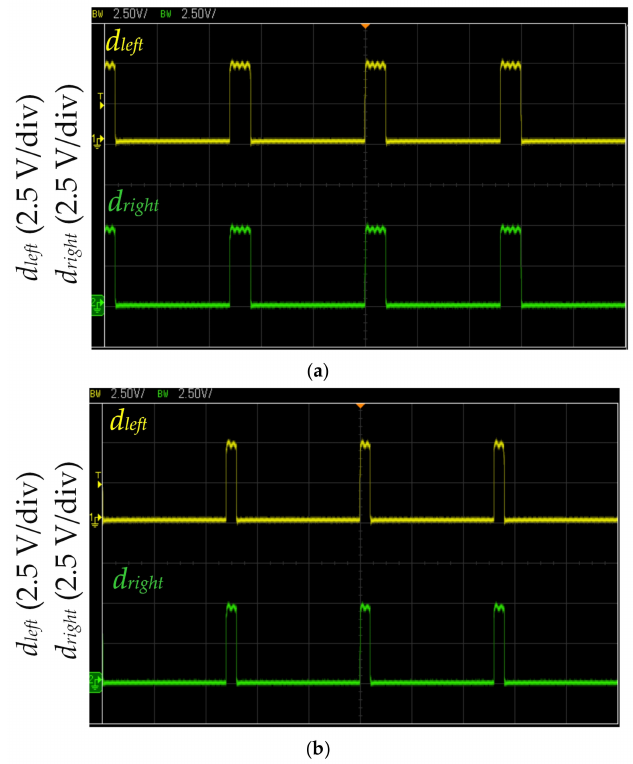
Figure 15. MCU output d left and d right waveforms of an obstacle ahead of the self-driving electric mobile robot: ( a ) with proposed LCOT control strategy and ( b ) with fixed duty cycle method. (The horizontal axis: 2 µ